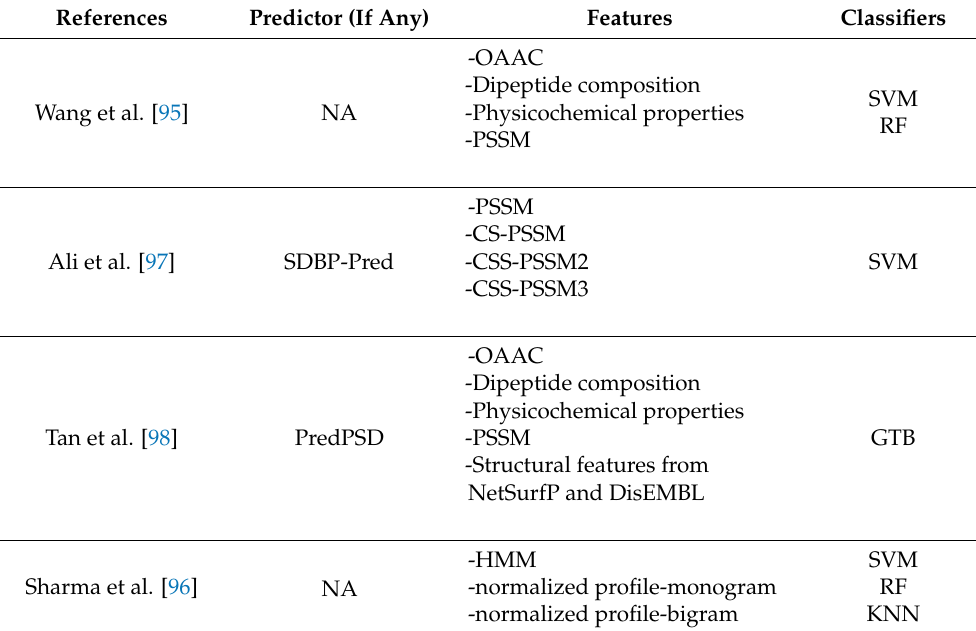
Table 1. Summary of machine learning-based SSB prediction